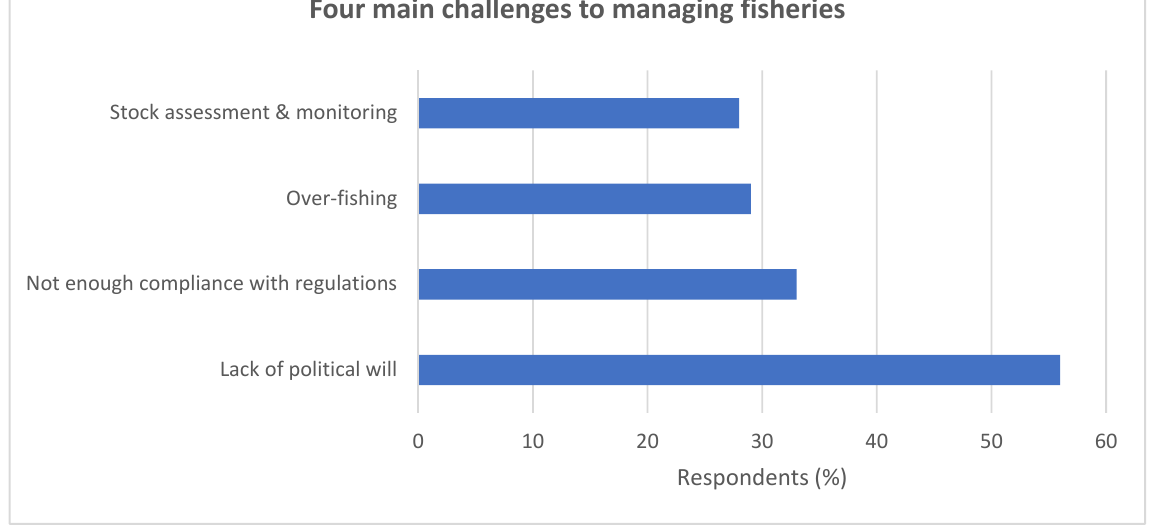
Figure 7. Expert opinions on four main challenges to managing fisheries (n = 174).